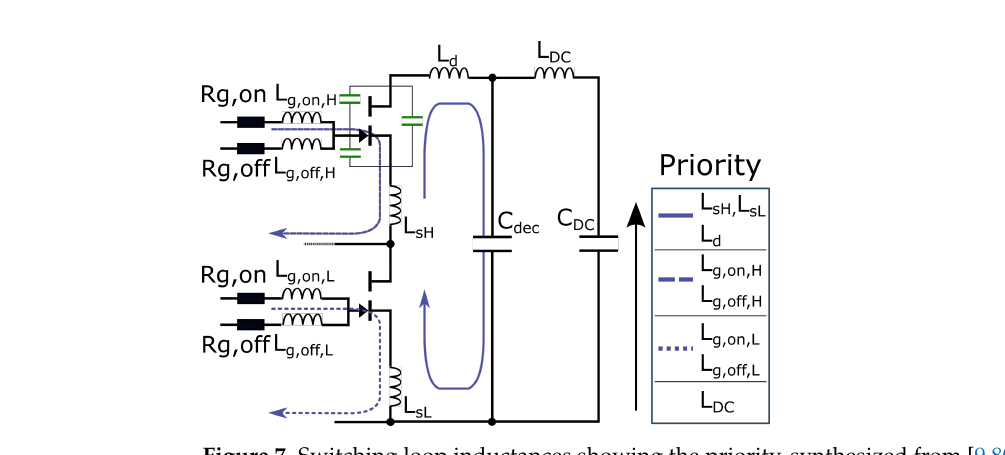
Figure 7. Switching loop inductances showing the priority, synthesized from